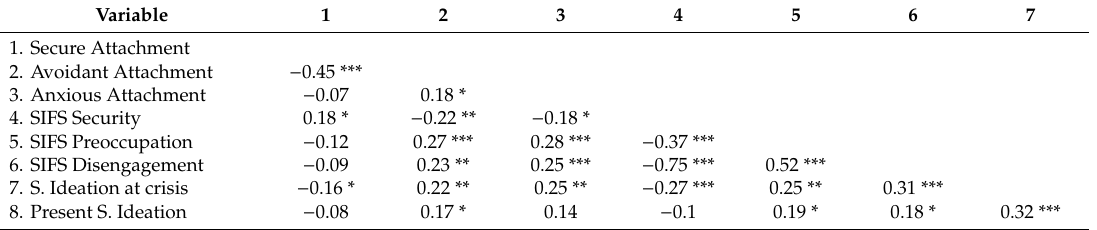
Table 3. Pearson correlations of all of the variables examined among non-victims ( n = 188) .